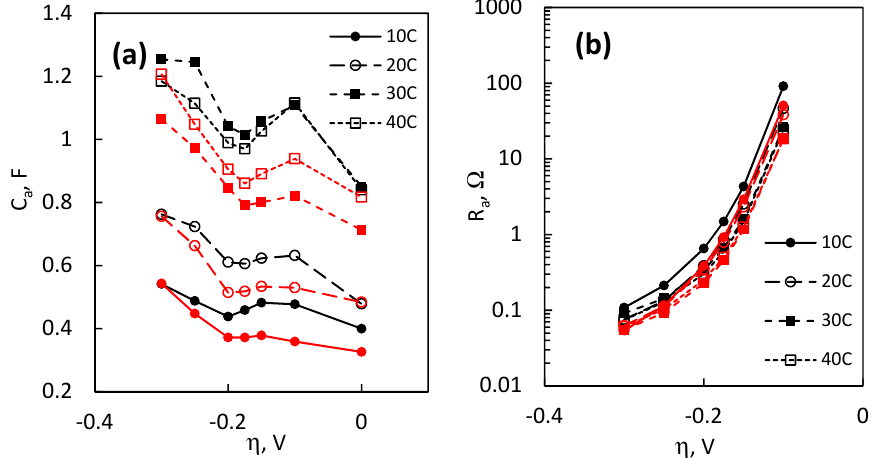
Figure 11. Values of the low-frequency RC circuit as a function of overpotential (red lines correspond to samples, deposited with NaH 2 PO 2 ): ( a ) capacitance, related to hydrogen adsorption and desorption, and ( b ) hydrogen adsorption resistance.